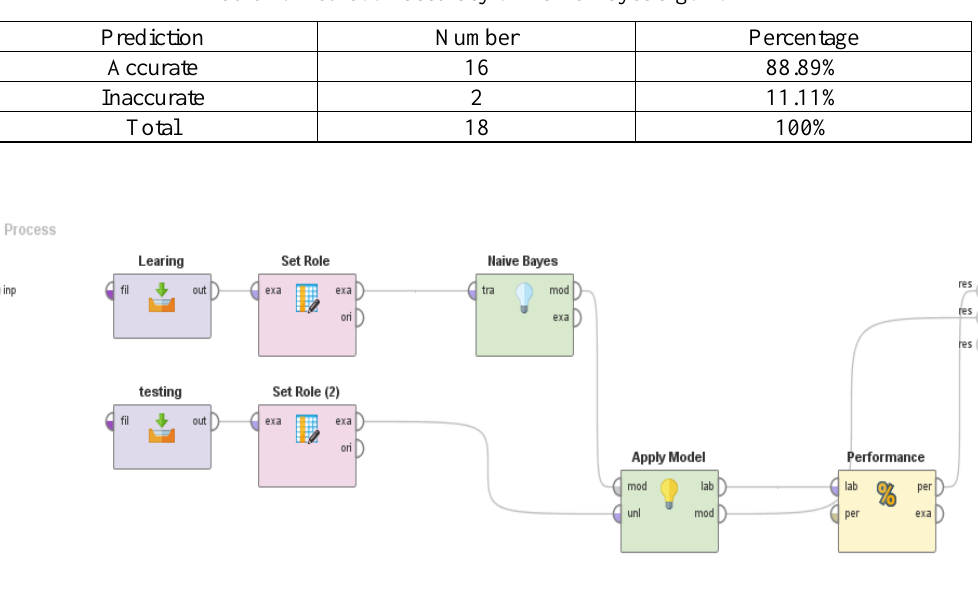
Figure5. Naive Bayes